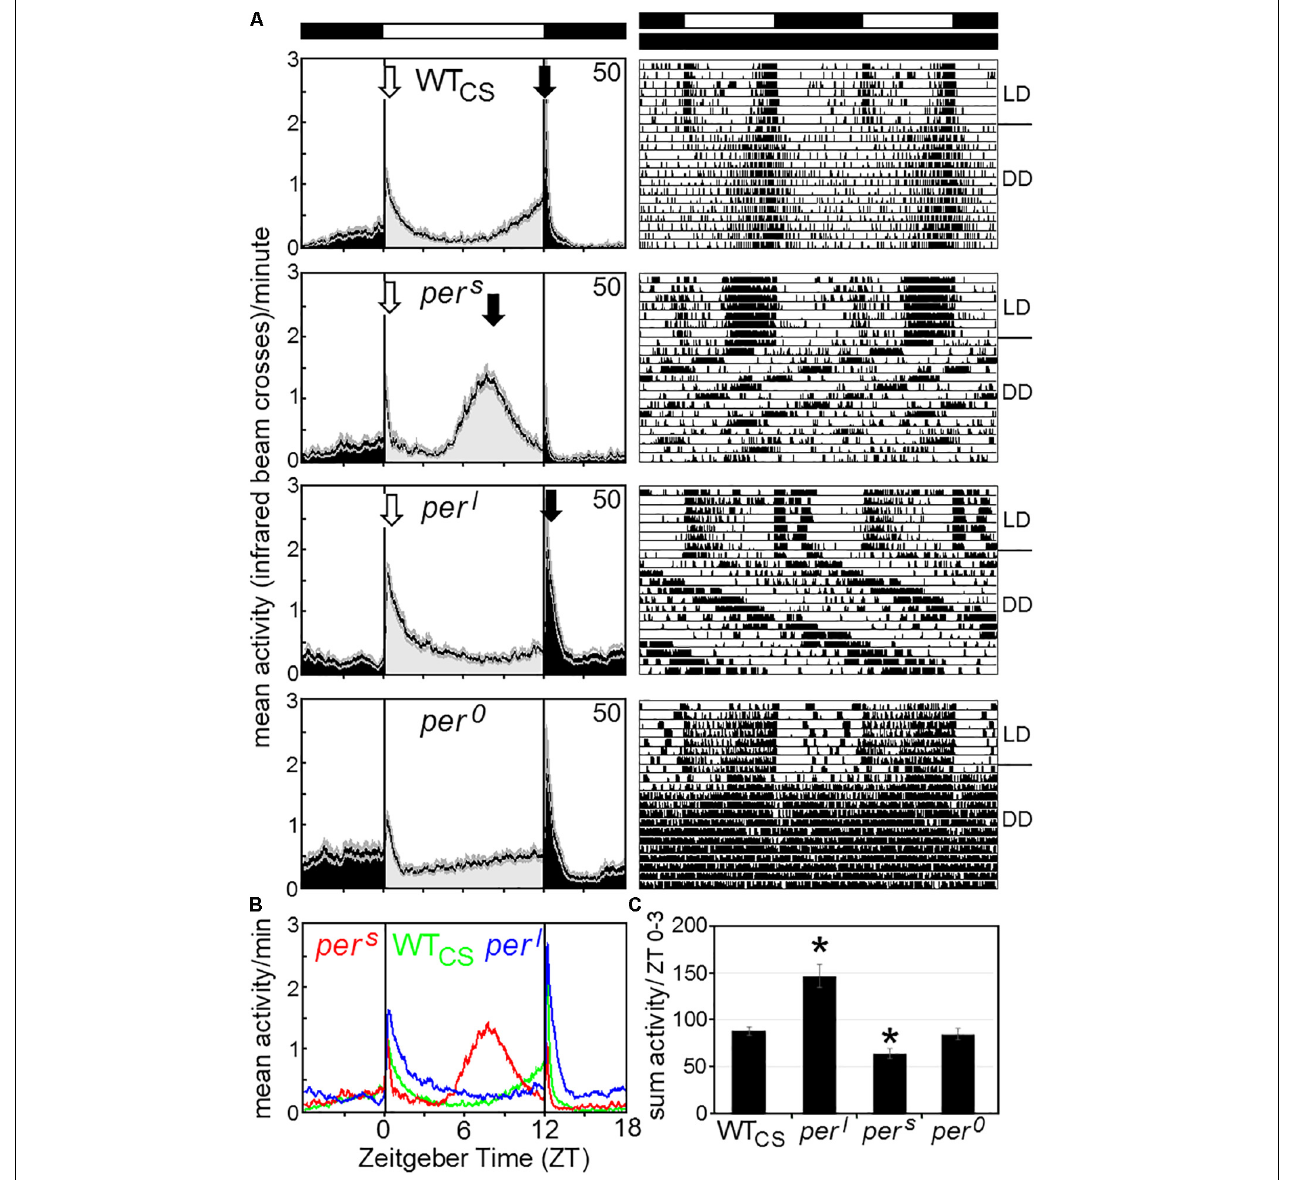
FIGURE 4 | Average activity profiles and typical actograms of individual wildtype (WT CS ) and period mutant ( per s , per l and per 0 ) flies under LD and constant darkness (DD). (A) : Under LD cycles, WT CS flies show a bimodal activity pattern with morning (open arrow) and evening (closed arrow) activity bouts. In per s mutants the evening activity bout is advanced into the early afternoon while it is delayed into the night in per l mutants. The morning activity bout appears to be reduced in per s mutants, while it is pronounced and long-lasting in per l mutants [see also (B,C) ]. per 0 mutants are active during the day and night and strongly respond to lights-on and lights-off, but lack evident morning and evening activity bouts. Under DD, the actograms (right diagrams) show that the WT CS fly free-runs with an endogenous period of ∼ 24 h, while the per s mutant free-runs with a short period, the per l mutant with a long period and the per 0 mutant becomes arrhythmic. (B) : Overlay of the average activity profiles of per s , WT CS and per l flies, showing the different phases of the evening activity bout and the different activity levels during morning activity. (C) : Sum of activity (beam crosses) during the first 3 h (ZT0-3) after lights-on for all fly strains. Significant differences to WT CS flies are indicated by